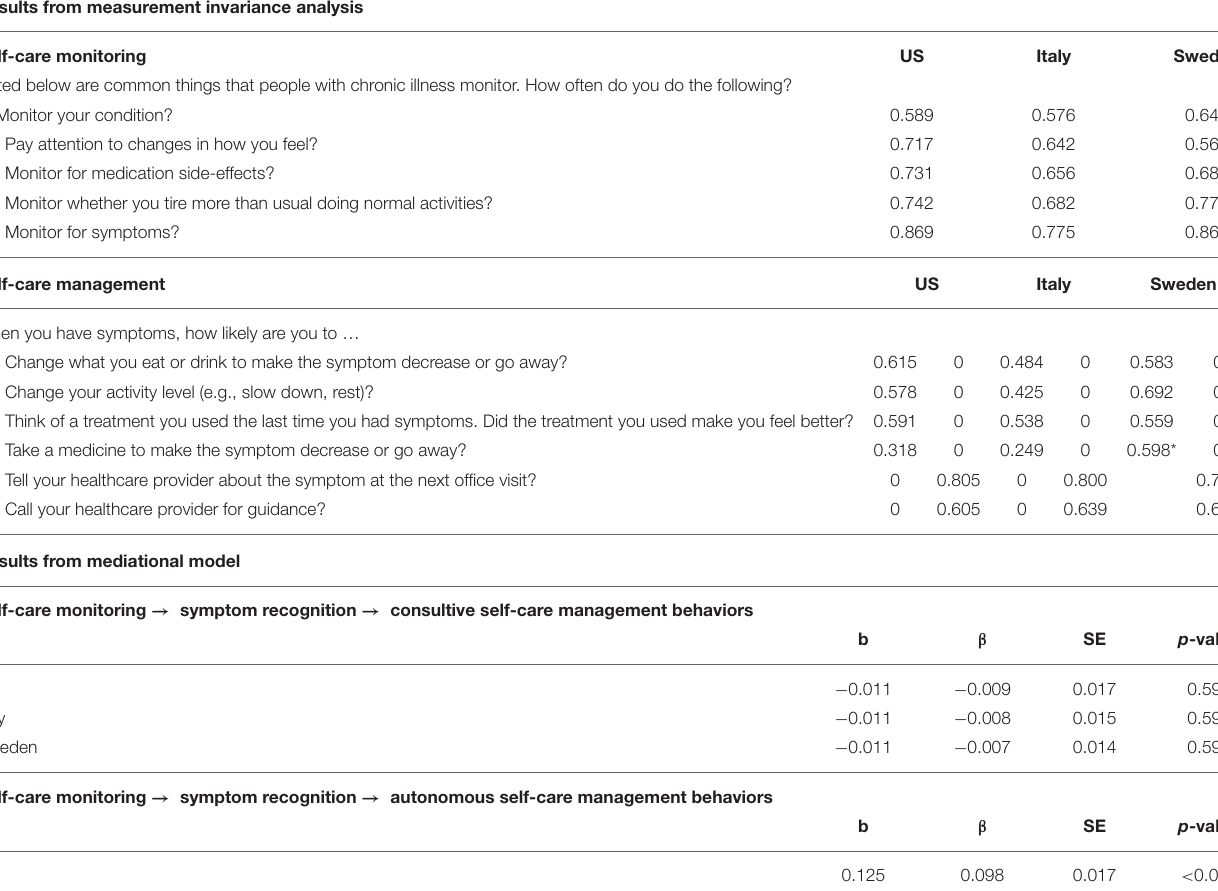
TABLE 1 | Parameter estimates from the final solution of the MG-CFA for testing measurement invariance, and from the mediational model tested on the US, Italian, and Swedish samples ( n = 1,615). Results from measurement invariance analysis Self-care monitoring